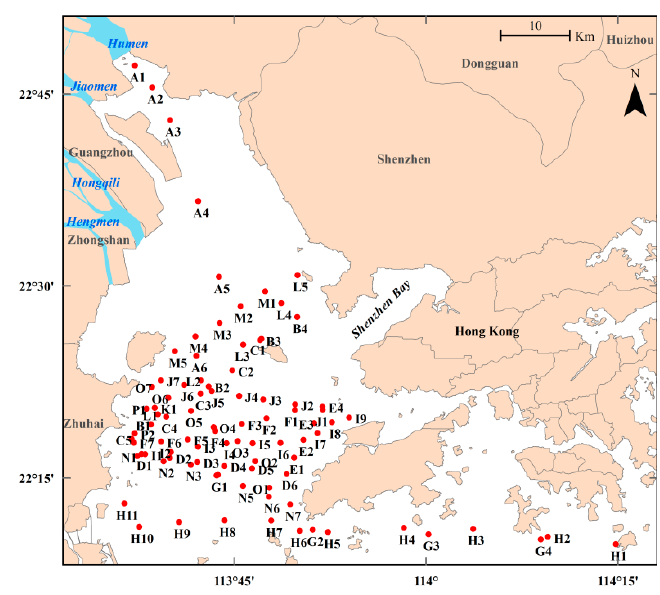
Figure 2. Location of the sampling stations for the May 2014 cruise in the Pearl River Estuary.